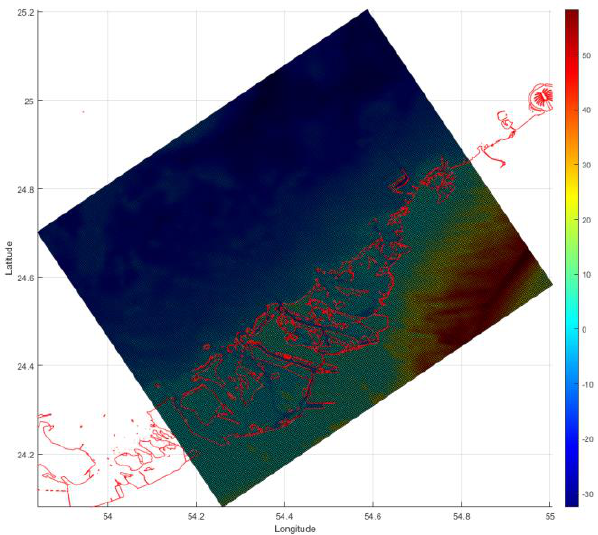
Figure 5. SWAN model computational domain, with coastline in red. Shading represents water or land elevation in meters above mean sea level.